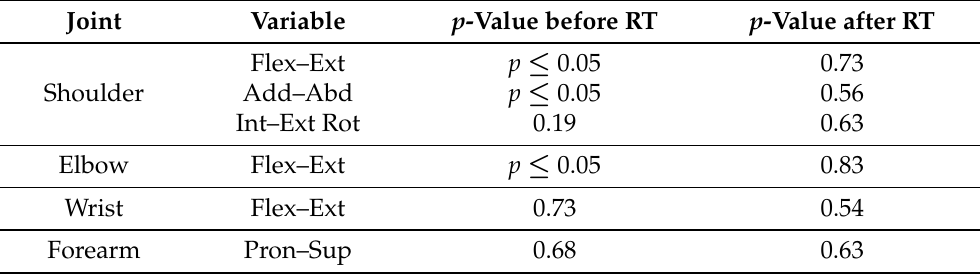
Table 5. RoM Wilcoxon test of the paretic and non-paretic limb in the Maximum Forward Reach Test before and after the rehabilitation therapy.